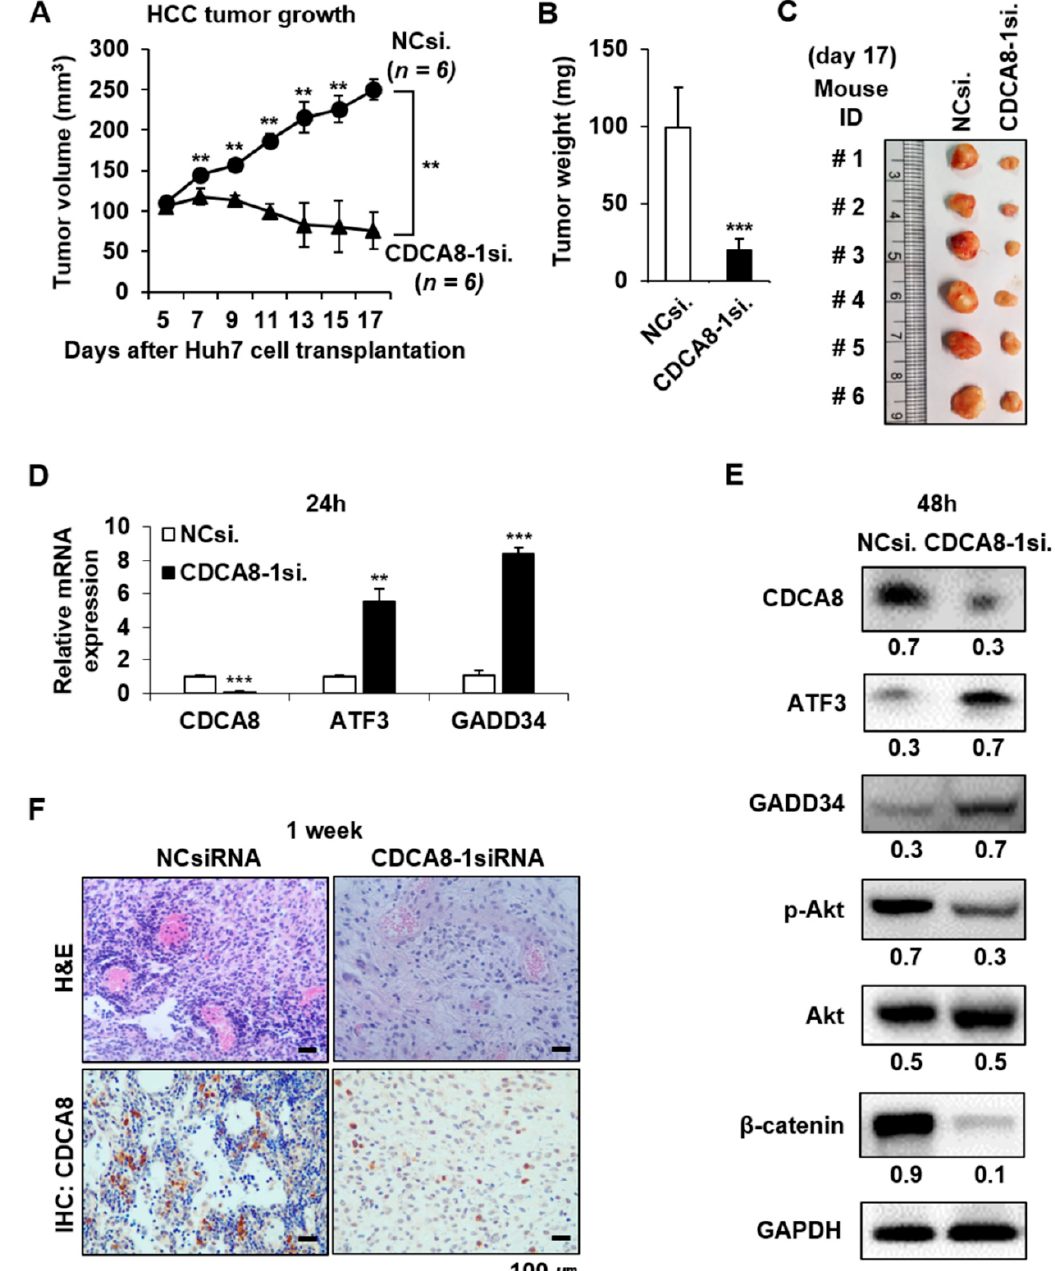
Figure 9. CDCA8 silencing suppresses HCC growth in vivo. ( A ) Kinetics of tumor growth: Huh7 cells transfected with NCsiRNA or CDCA8-1 siRNA for 24 h were subcutaneously injected into nude mice. Tumor diameters were measured on the indicated days with digital calipers (** p < 0.01 ( n = 6 vs. n = 6)) by normality assumption test. ( B , C ) Average tumor weight ( B ) and gross tumor morphology ( C ) at 17 days after Huh7 cell transplantation. ( D ) Detection of mRNA expression of CDCA8, ATF3, and GADD34 genes in tumors 24 h after the third injection of CDCA8-1siRNA. ** p < 0.01; *** p < 0.001 vs. control. ( E ) Levels of CDCA8 and the indicated proteins in tumors 48 h after the third injection of CDCA8-1siRNA. ( F ) Detection of proliferative tumor cells and CDCA8 target protein in tumors 1 week after the third injection of CDCA8- 1siRNA. Scale bar = 100 μ m.